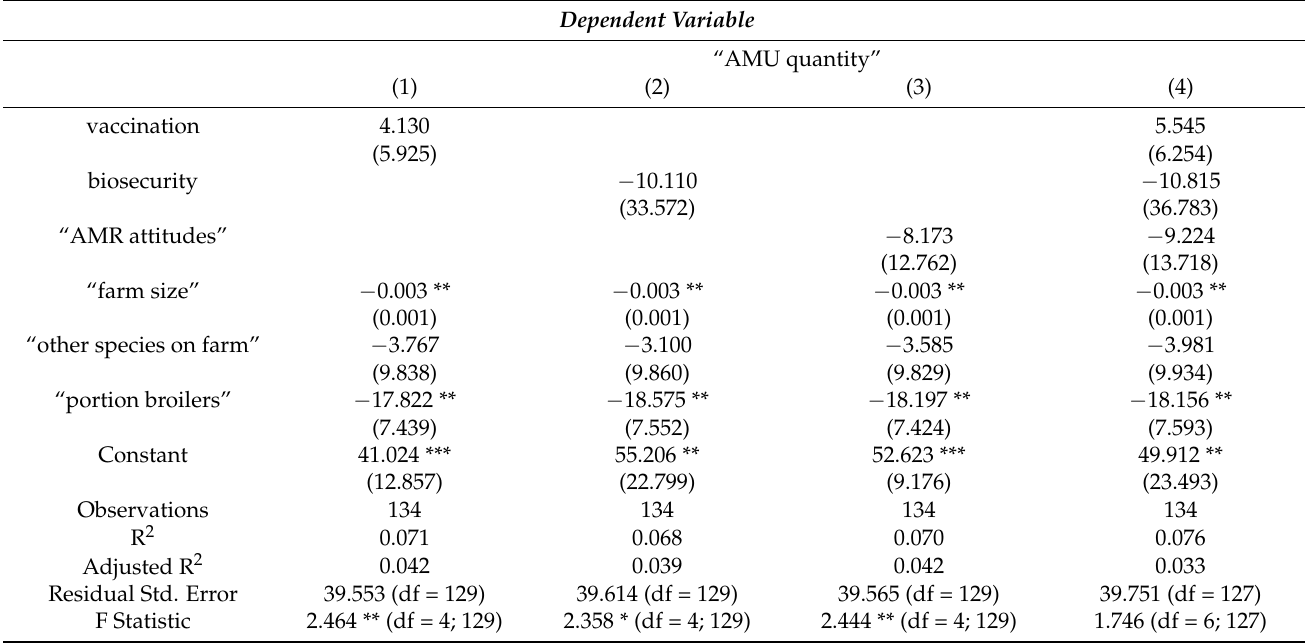
Table 2. Determinants of AMU